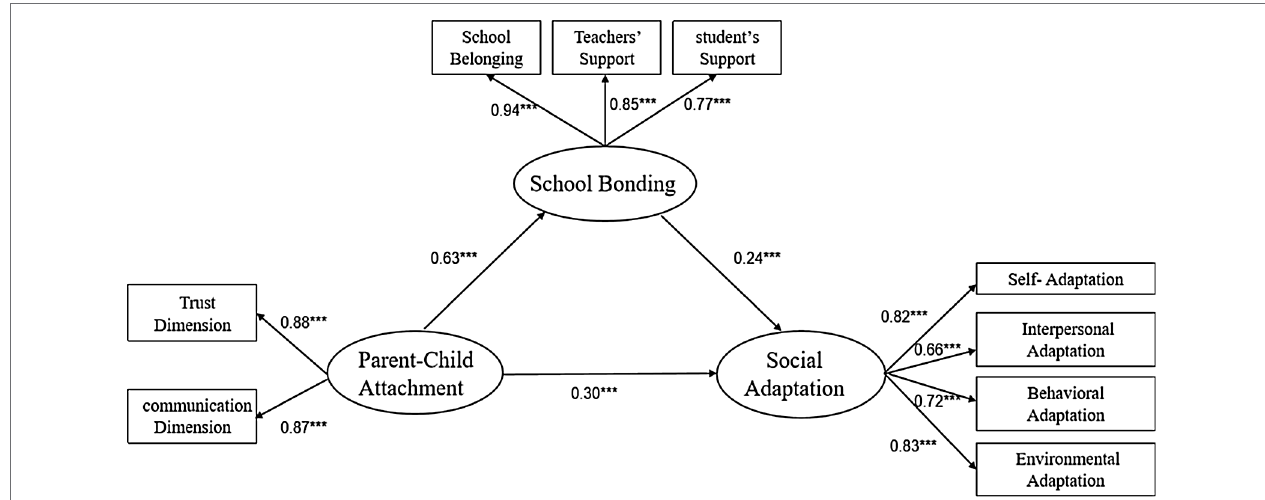
FIGURE 2 | Mediation model of school bonding between parent-child attachment and social